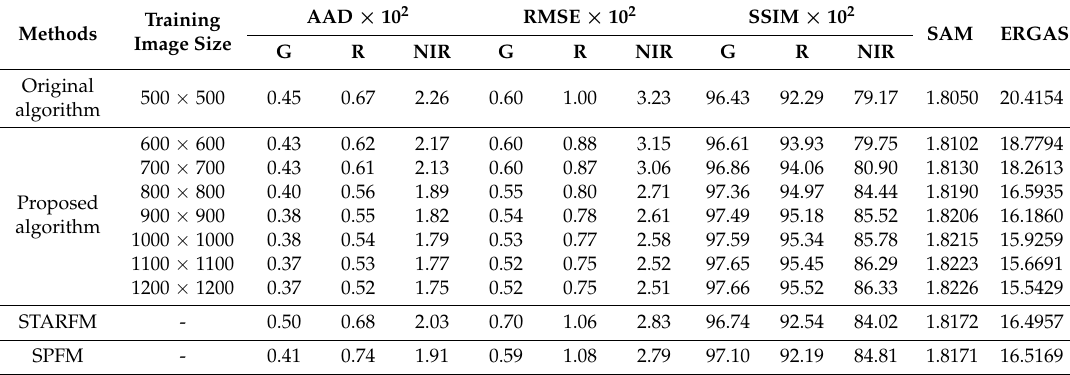
Table 3. Assessment indices of the spatially extended fusion for modeling reflectance on 11 July 2001 of the rural